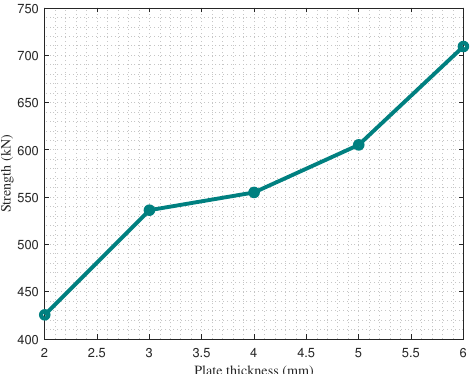
Figure 8. Shear wall strength S for different values of plate thickness t .